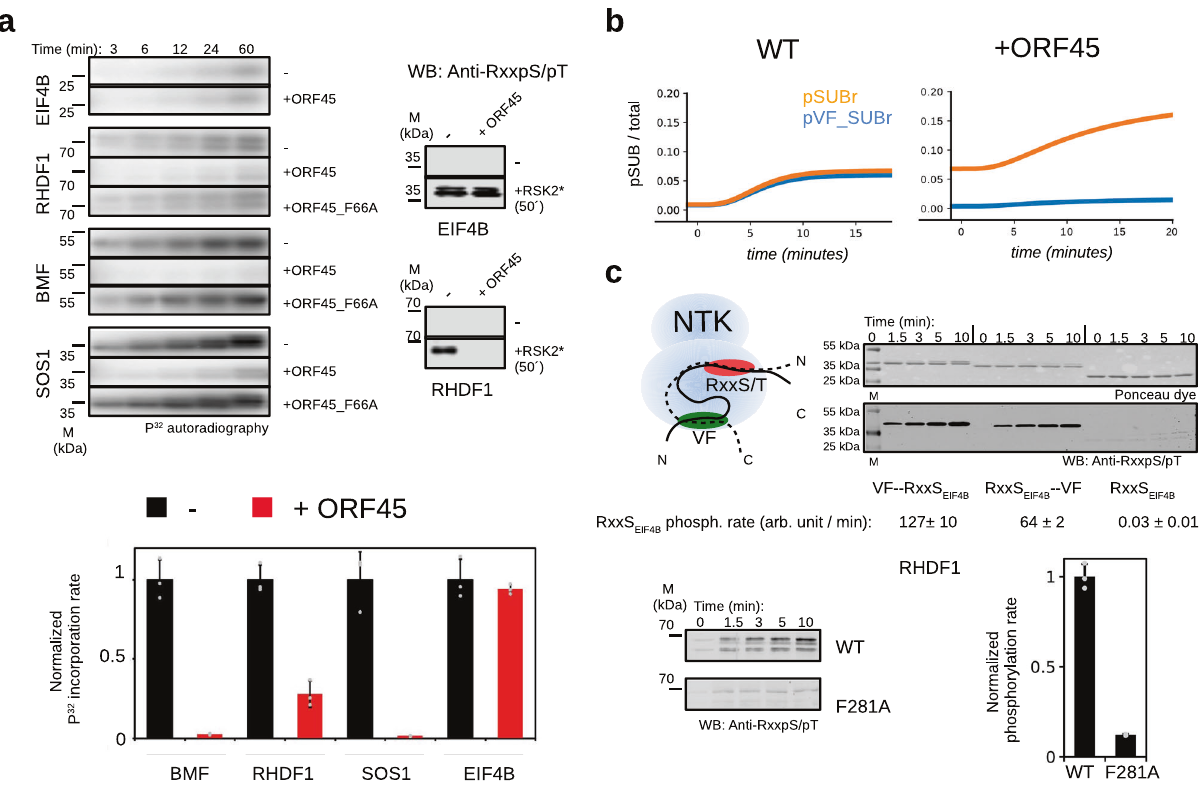
Fig. 8 VF-motif mediated phosphorylation of RSK substrates. a In vitro kinase assay results with VF-motif containing human proteins: BMF (full-length), SOS1(1101-1170), RHDF1 (1-289), and with a VF-motif lacking substrate (EIF4B). The panels below show the results of in vitro kinase assays: P 32 - autoradiography based detection by phosphorimaging is shown on the left and the Western-blots using the anti-RxxpS/pT phosphorylation sensitive antibody on the right con fi rms AGC kinase-speci fi c site (RxxS/T) phosphorylation for EIF4B and RHDF1 after 50 min. 0.5 µ M activated RSK2 was mixed with 10 µ M GST-fusion constructs (EIF4B: 411-ETQERERSRTGSESSQTGTS-430; full-length BMF, SOS1(1101-1171), and RHDF1(1-289)), and the substrate phosphorylation was monitored in the absence (-) or presence of 2 µ M competitor: GST-ORF45(16-76) or the VF-motif mutated version of the latter (ORF45_F66A). The bar charts below show the initial phosphorylation rate normalized to the reaction containing no competitor. Error bars show SD calculated based on three independent experiments. P -values of two-sided paired t-tests were the following: BMF, p = 1.8E − 4; RHDF1, p = 5.4E − 4; SOS1; p = 6.4E − 4; EIF4B: p = 0.5. b Simulation results showing the effect of ORF45 on the phosphorylation levels of VF-motif independent (SUBr) and VF-motif dependent (VF-SUBr) substrates after EGF stimulation. The plots were generated using the Network Model (Fig. 6). c Enhanced phosphorylation of the RxxS/T motif through VF-motif-based RSK docking. RxxS/T substrate phosphorylation sites bind in the negatively charged substrate-binding pocket of NTK (depicted with a red ellipsoid; RxxS EIF4B indicates the 411-430 region from EIF4B, see Panel a ). A VF-motif located N- or C-terminally — VF-RxxS EIF4B or RxxS EIF4B -VF, respectively — to this phosphorylation site may enhance the rate of phosphorylation through VF groove (shown with a green ellipsoid) based docking. The phosphorylation rate of 10 µ M GST-fusion constructs containing the EIF4B RxxS/T phosphorylation site alone (RxxS EIF4B ) or in combination with the VF-motif from ORF45 (VF: ORF45_a, see Fig. 7b; VF-RxxS EIF4B or RxxS EIF4B -VF; where the F and S from these two motifs were separated by 34 or 20 amino acids, respectively) were examined in kinase assays using 100 nM activated RSK2. The upper panel shows the gel stained with a protein dye (Ponceau) and the lower panel shows the quantitative Western-blot signal obtained with the phosphorylation-speci fi c Anti-RxxpS/pT antibody. Phosphorylation rates (mean) were calculated based on the linear phase of the kinetic plots and the SD was calculated based on three independent experiments ( N = 3). The panels at the bottom show the diminished phosphorylation rate of the RxxS motifs in RHDF1 (5 µ M RHDF1 1-289 with 0.25 µ M activated RSK2) when the VF motif was mutated (F281A). Source data are provided as Source data fi